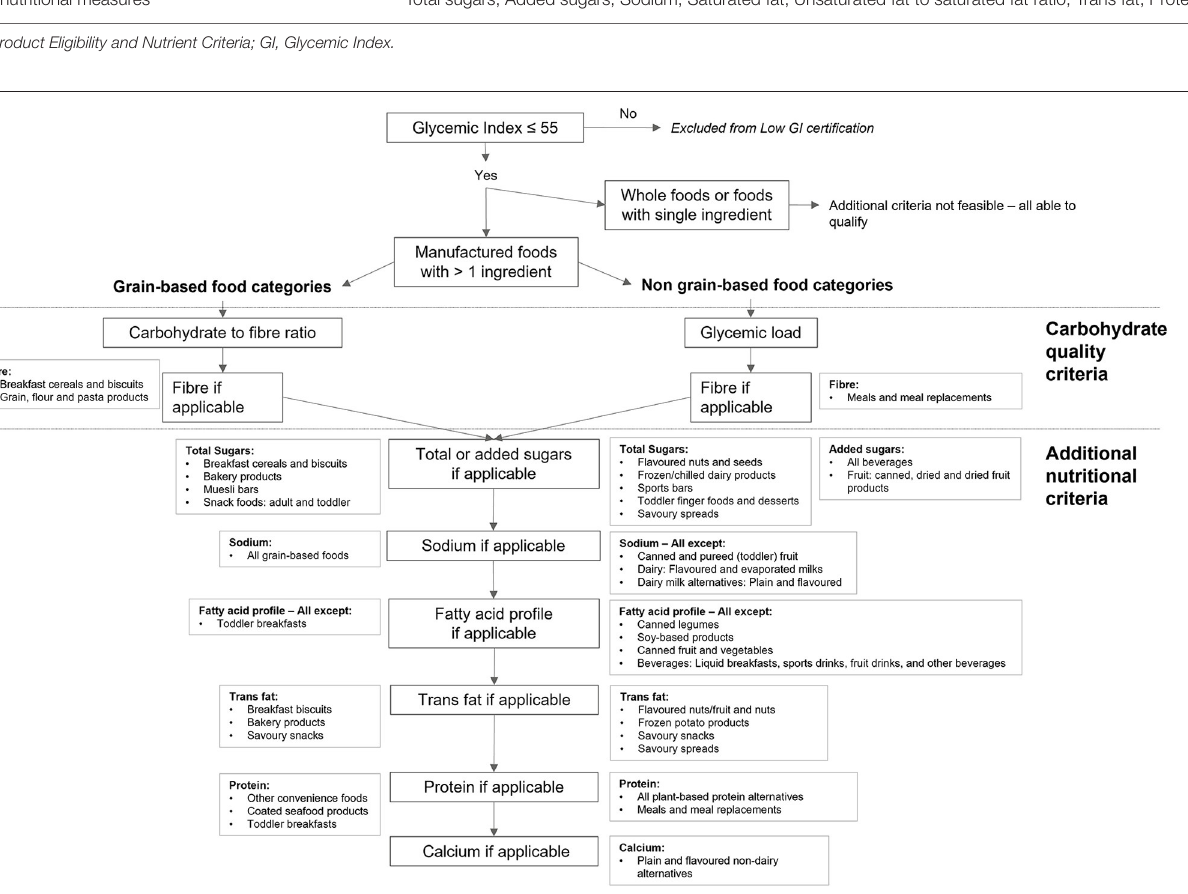
FIGURE 2 | Overview of the nutritional measures determined for each food category covered by the GI Symbol PENC. All foods must have GI ≤ 55 to be considered for the GI Symbol. Reformulation was not considered feasible for whole foods of foods with a single ingredient; these foods were not subject to additional criteria. Manufactured foods with more than one ingredient were separated into grain-based and non-grain-based food categories. The criteria for grain-based food categories included the carbohydrate to fiber ratio and absolute fiber if necessary; the criteria for non-grain-based food categories used glycemic load in place of